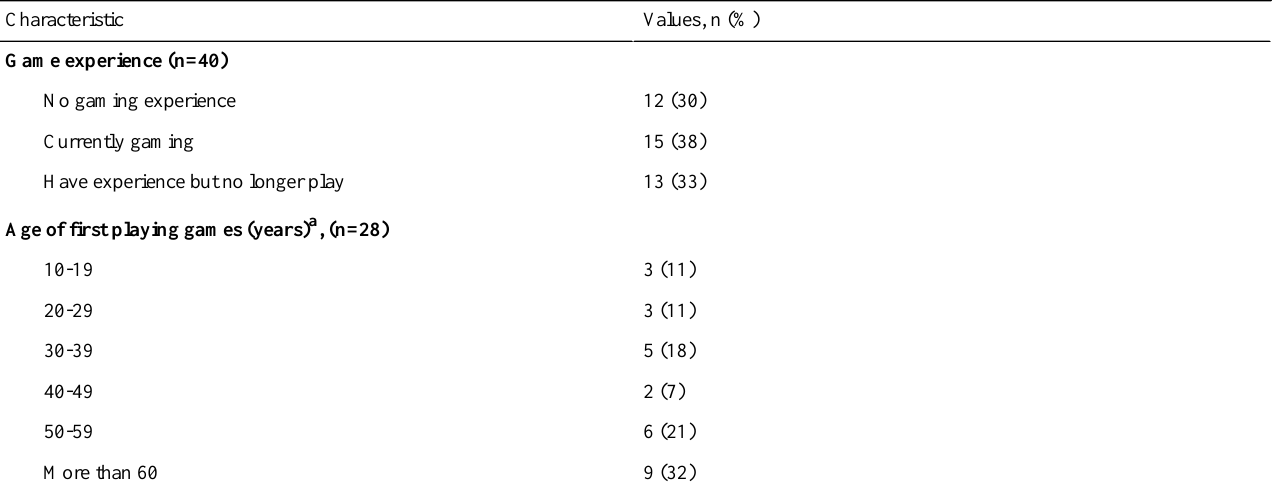
Table 2. Prior gaming experience of the participants.